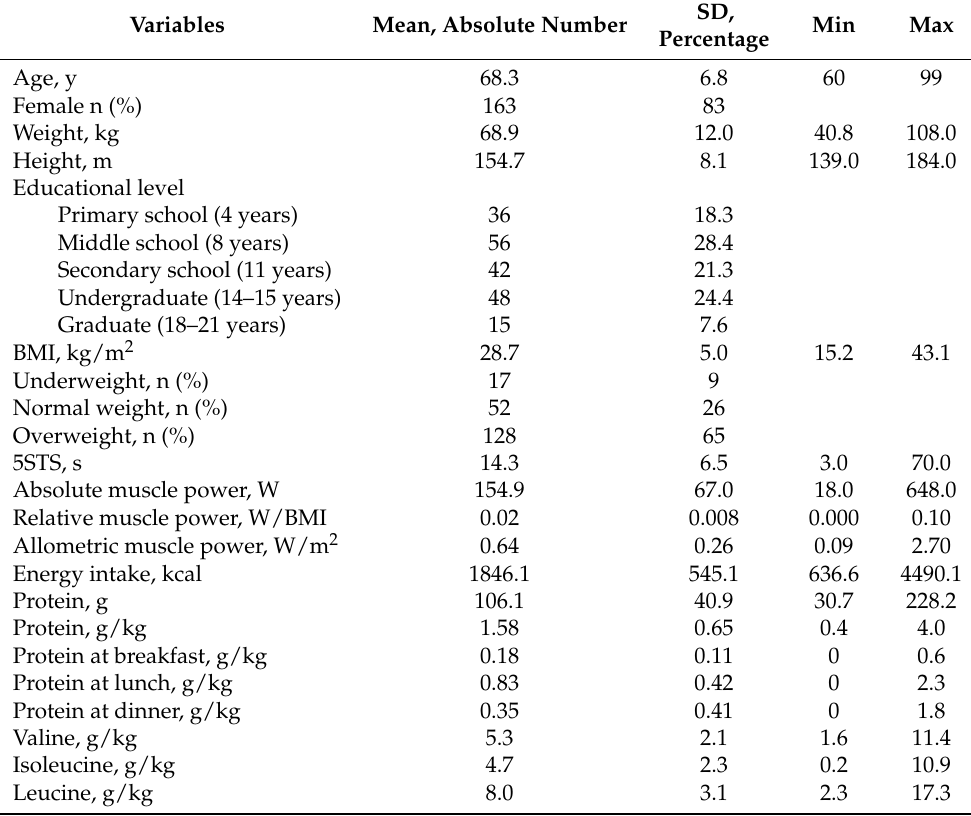
Table 1. Main characteristics of study participants ( n =